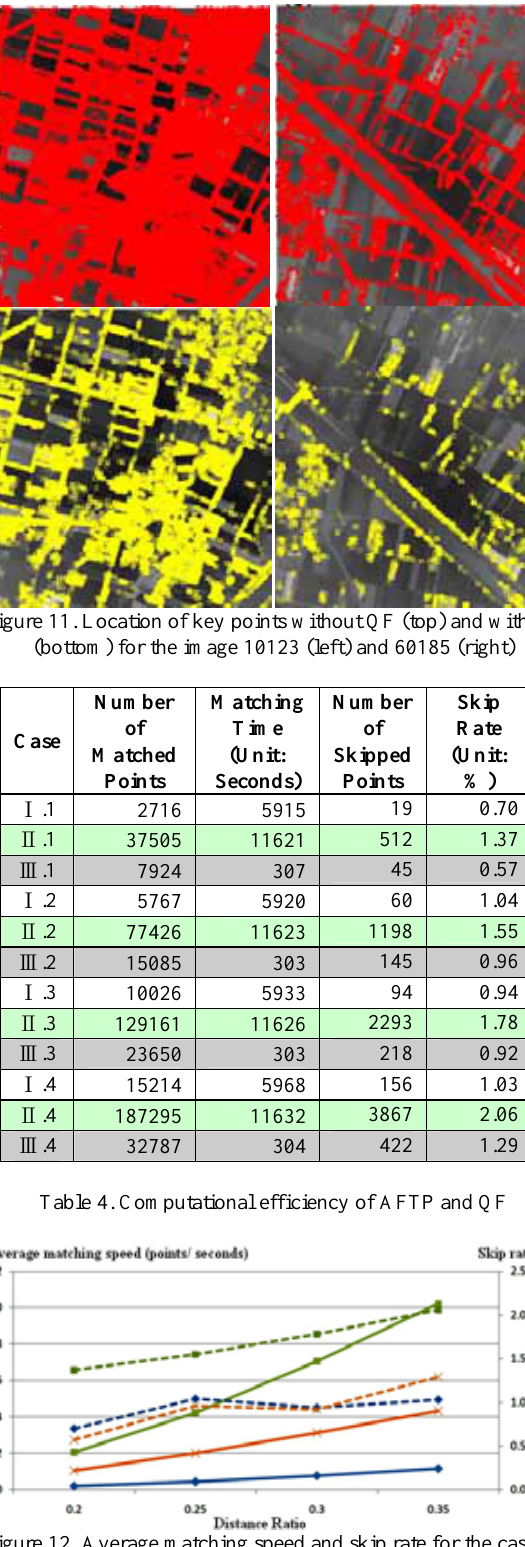
Figure 12. Average matching speed and skip rate for the cases I, II and III denoted by blue, yellowgreen and orange colour; solid and dashed lines denote average matching speed and skip rate,